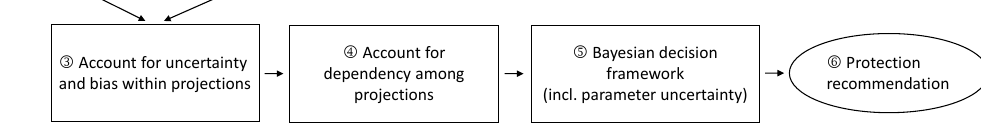
uncertainty refers to uncertainty components that cannot be quantified from the given projections and data. For